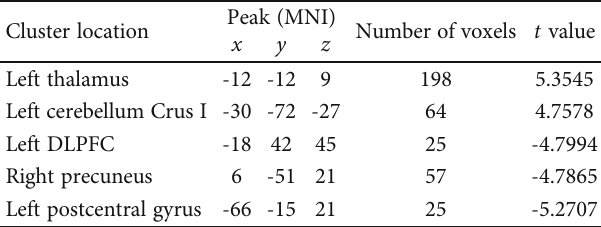
Table 2: Regions with abnormal degree values in the patients with